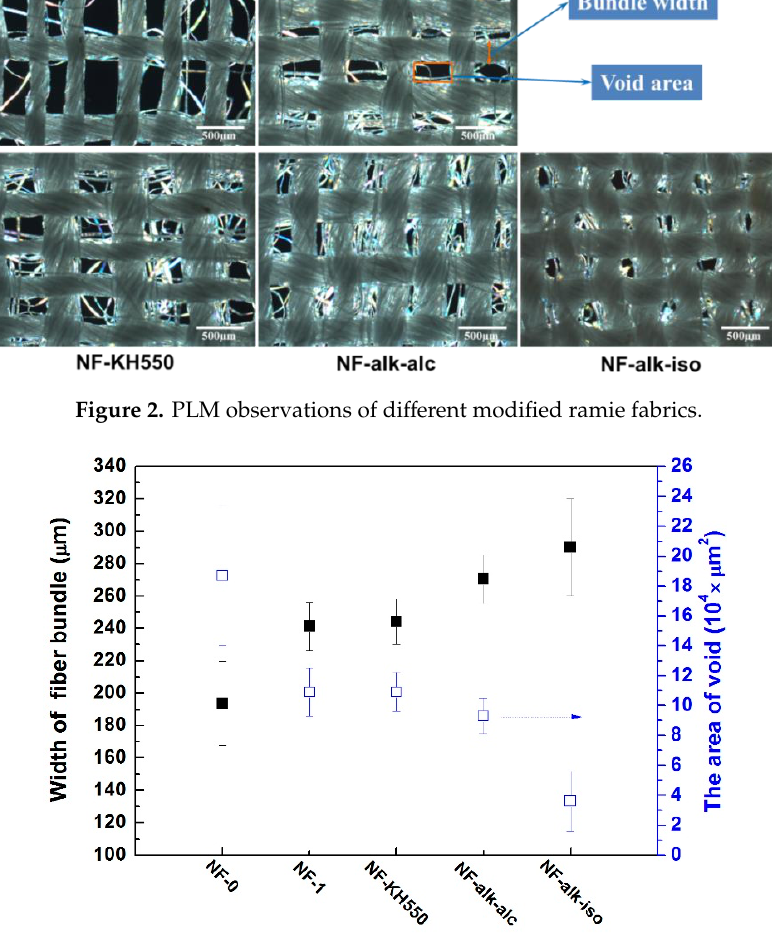
Figure 3. The variation of the fiber bundle width (black square) and the void area of different modified ramie fabrics (blue square).